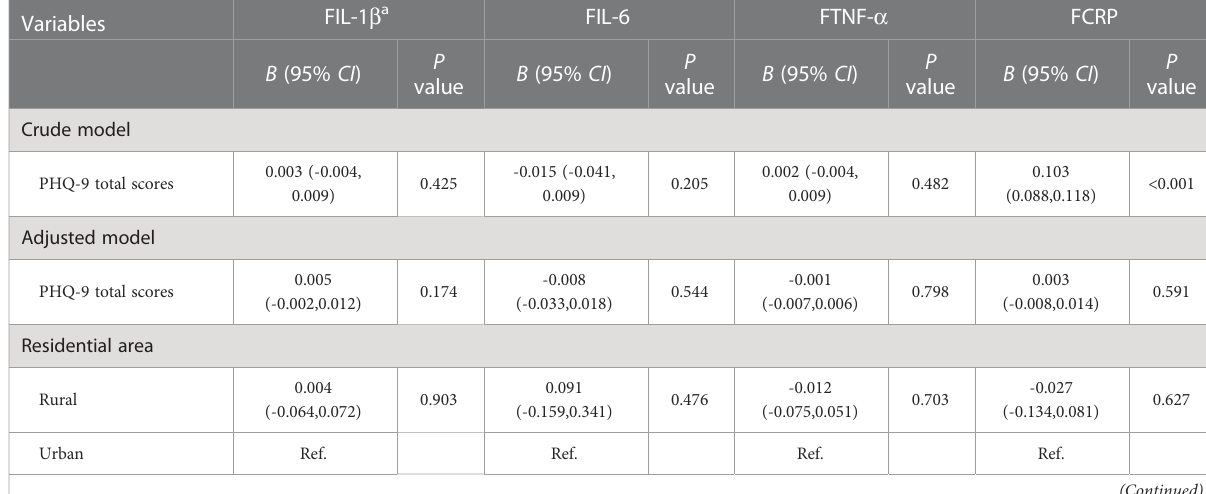
TABLE 3 Generalized linear models of the associations between PHQ-9 total scores at baseline and in fl ammatory biomarkers at follow-up (n=248).